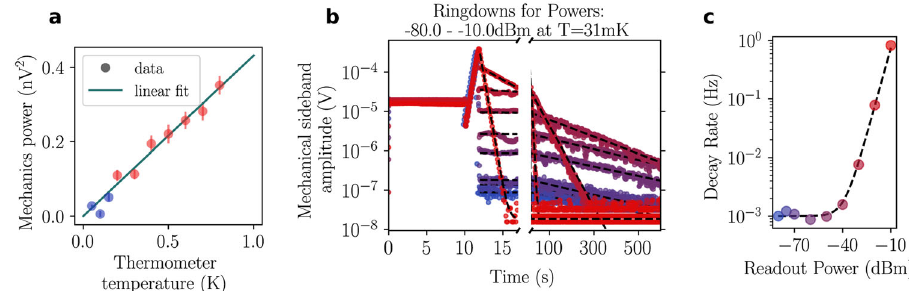
Fig. 3 Electromechanical calibration. a The mechanical occupation is calibrated by thermal anchoring at temperatures above 200 mK. The linear relationship between the area of the mechanical peak in the spectrum and the sample holder temperature con fi rms that the mechanics is thermalized. Only the red data are used for the fi t (see main text). Error bars are std. dev. of the mechanical sideband area fi ts. b A mechanical energy ringdown series measured as function of the applied cooling power, measured at 30 mK. Overlayed temporal series show repeatable initialization of the mechanical energy (up to ~12 s) and increasing decay rates as the cooling power is turned up. c The fi t of mechanical decay rates gives the intrinsic decay rate Γ m , without dynamical backaction, and the corner power P 0 , where the cooling rate Γ e ( P 0 ) is equal to Γ m . Points' color code is the same as in panel ( b